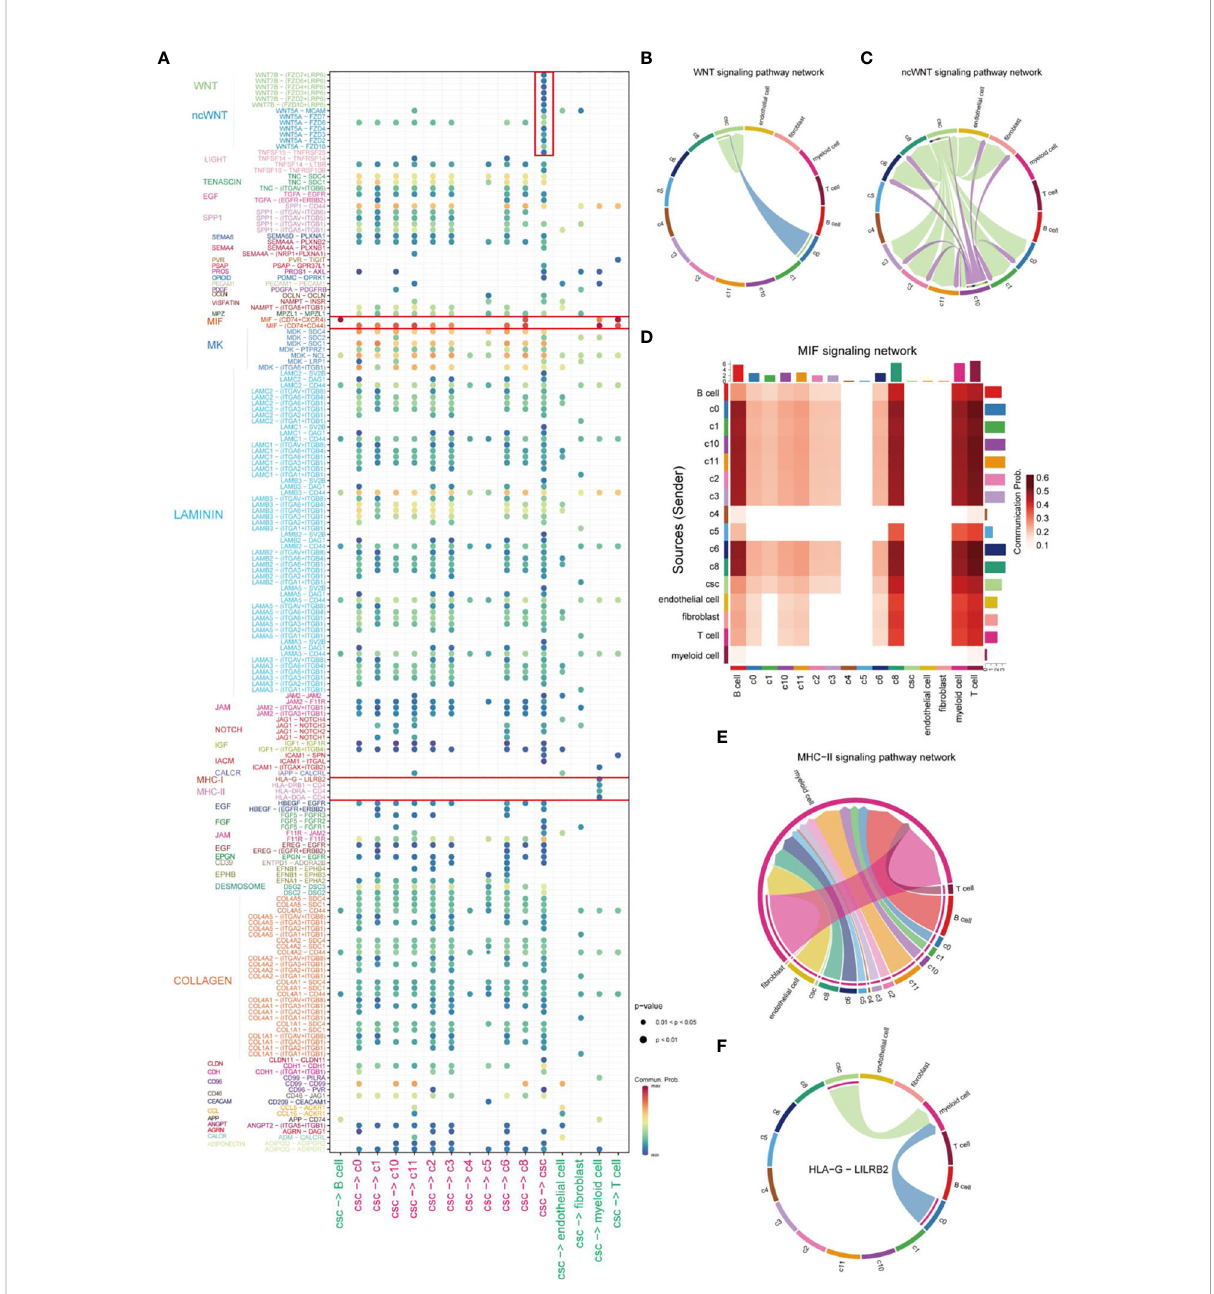
FIGURE 3 Comprehensive analysis of cell-cell interactions in HNSCC. (A) Ligand-receptor pair association analysis of cellular-cell interaction between CSC and other cells in HNSCC. (B) Plot of cells which interacted via WNT signaling pathways in HNSCC. (C) Plot of cells which interacted via ncWNT signaling pathways in HNSCC. (D) Cells involved in MIF signaling networks in HNSCC. (E) Plot of cells which interacted via MHC-II signaling networks in HNSCC. (F) Signal transduction of HLA-G-LILBR2 receptor-ligand pair of HLA signal in